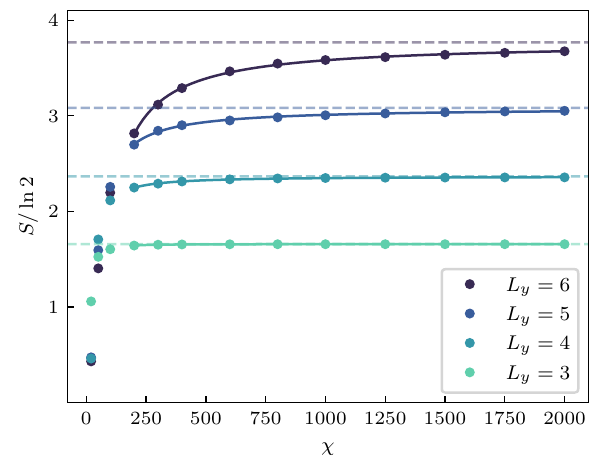
FIG. 8. Extrapolation of the entanglement entropy to infinite bond dimensions. We use extrapolation functions of the form S = S inf − b χ − c to determine the entanglement entropy S inf for χ → ∞